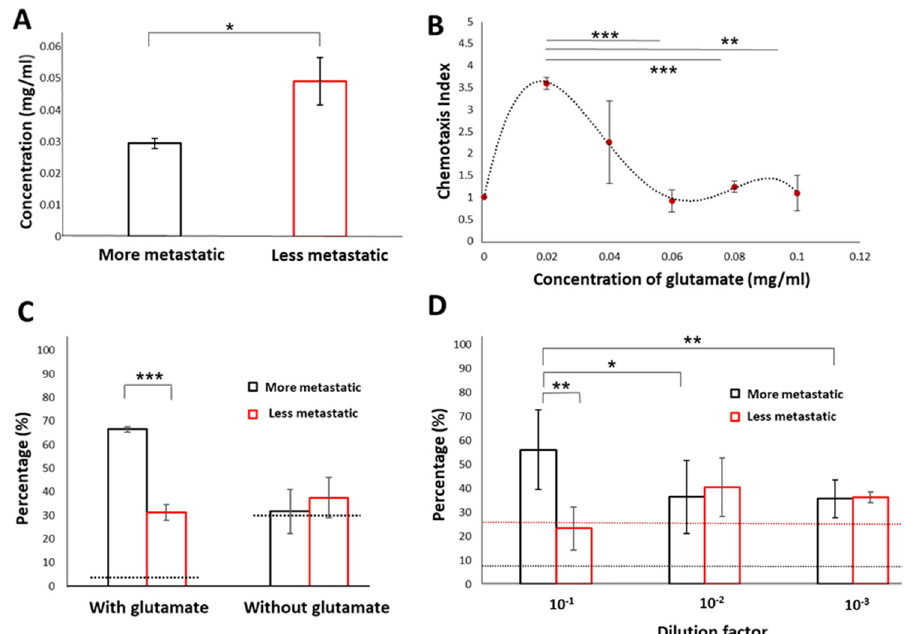
Figure 4. Glutamate acts as a chemorepellent to reflect the presence of metastatic phenotypes. ( A ) Glutamate levels in samples from cancer cells of the more metastatic phenotype (MDA-MB-231) and cancer cells of the less metastatic phenotype (MCF-7). ( B ) Quantitative evaluation of outcomes from the WB biosensor by establishing a chemotaxis index (CI). A range of glutamate concentrations (0.02 mg/mL, 0.04 mg/mL, 0.06 mg/mL, 0.08 mg/mL, and 0.1 mg/mL) was evaluated. ( C ) The proportion of C. elegans under exposure to samples from cancer cells of the more metastatic phenotype (MDA-MB-231) and cancer cells of the less metastatic phenotype (MCF-7) before and after glutamate degradation. The dotted line corresponded to the averaged value obtained with PBS buffer standards. ( D ) Evaluation of the detection limit for the WB biosensor. The black dotted line reflected the threshold determined by the rate of false-positives (8.71 ± 0.033%). The red dotted line reflected the thresh- old determined by the averaged value obtained with undiluted MCF-7 samples (25.73 ± 0.054%). *** states for p < 0.0005, **states for p < 0.005 * states for p < 0.05.